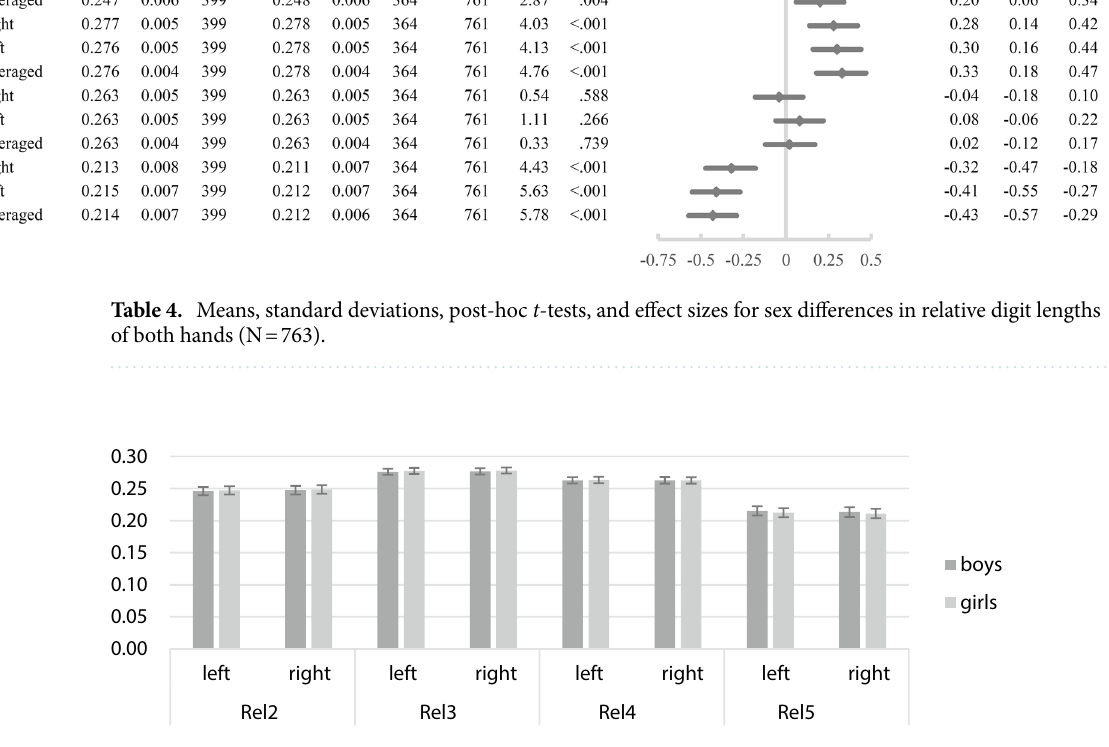
Figure 4. Means and standard deviations in right, left, and averaged relative digit lengths separately for boys, and